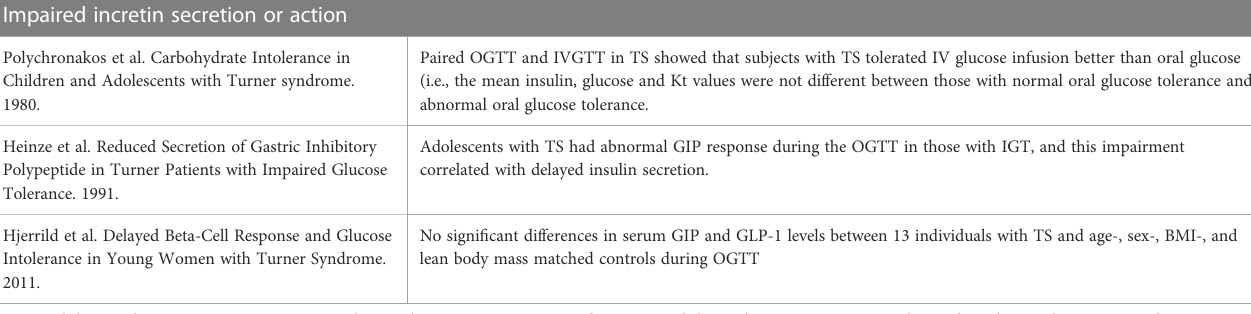
TABLE 7 Summary of studies evaluating impairment in incretin secretion or action to underly the TS-associated hyperglycemia phenotype. Impaired incretin secretion or action Polychronakos et al. Carbohydrate Intolerance in Children and Adolescents with Turner syndrome.